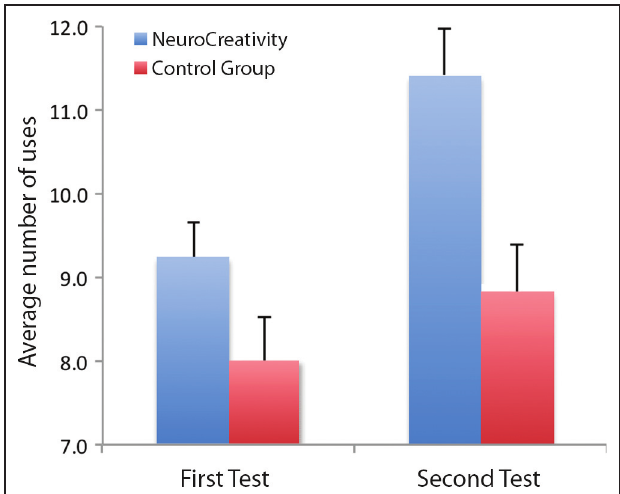
FIGURE 2 | The average number of uses generated per object on the first and second test for each group. Error bars represent the standard error of the mean.